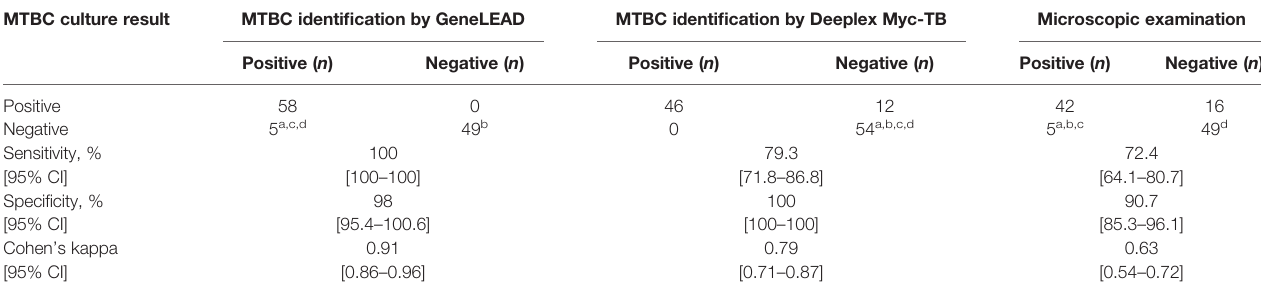
TABLE 3 | Performances of GeneLEAD/Deeplex Myc-TB assay and microscopic examination for the detection of M. tuberculosis complex in 112 specimens, in comparison with culture. MTBC culture